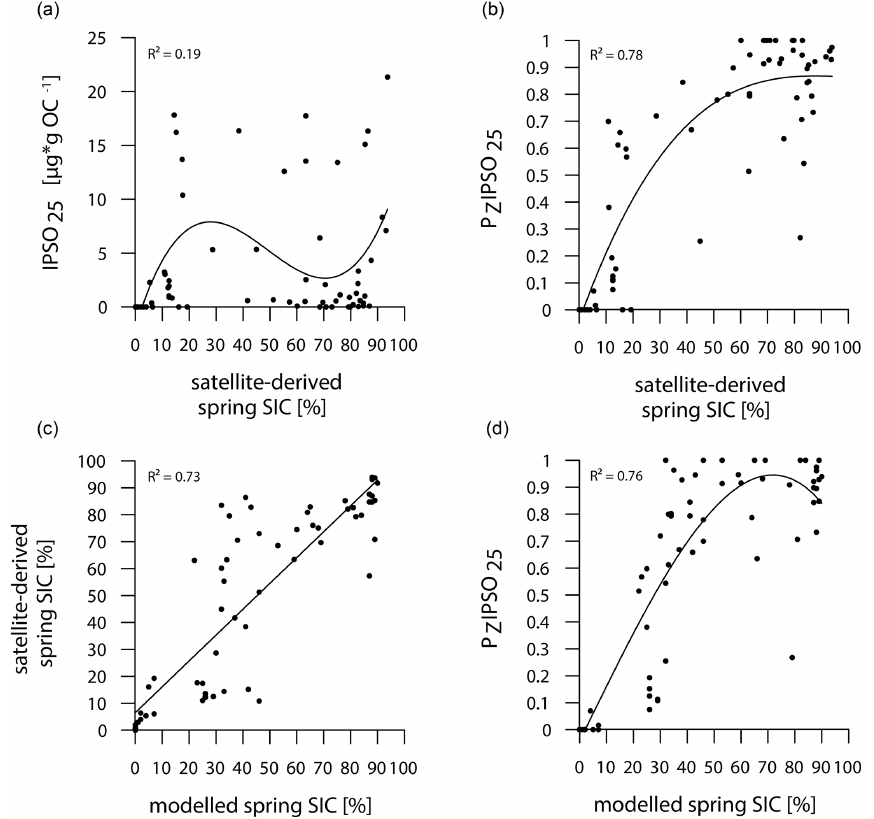
Figure 5. Correlations of (a) IPSO 25 concentrations vs. satellite-derived spring SIC, (b) P Z IPSO 25 values vs. satellite-derived spring SIC, (c) satellite-derived spring SIC vs. modelled spring SIC and (d) P Z IPSO 25 values vs. modelled spring SIC. Coefficients of determination ( R 2 ) are given for the respective regression lines.